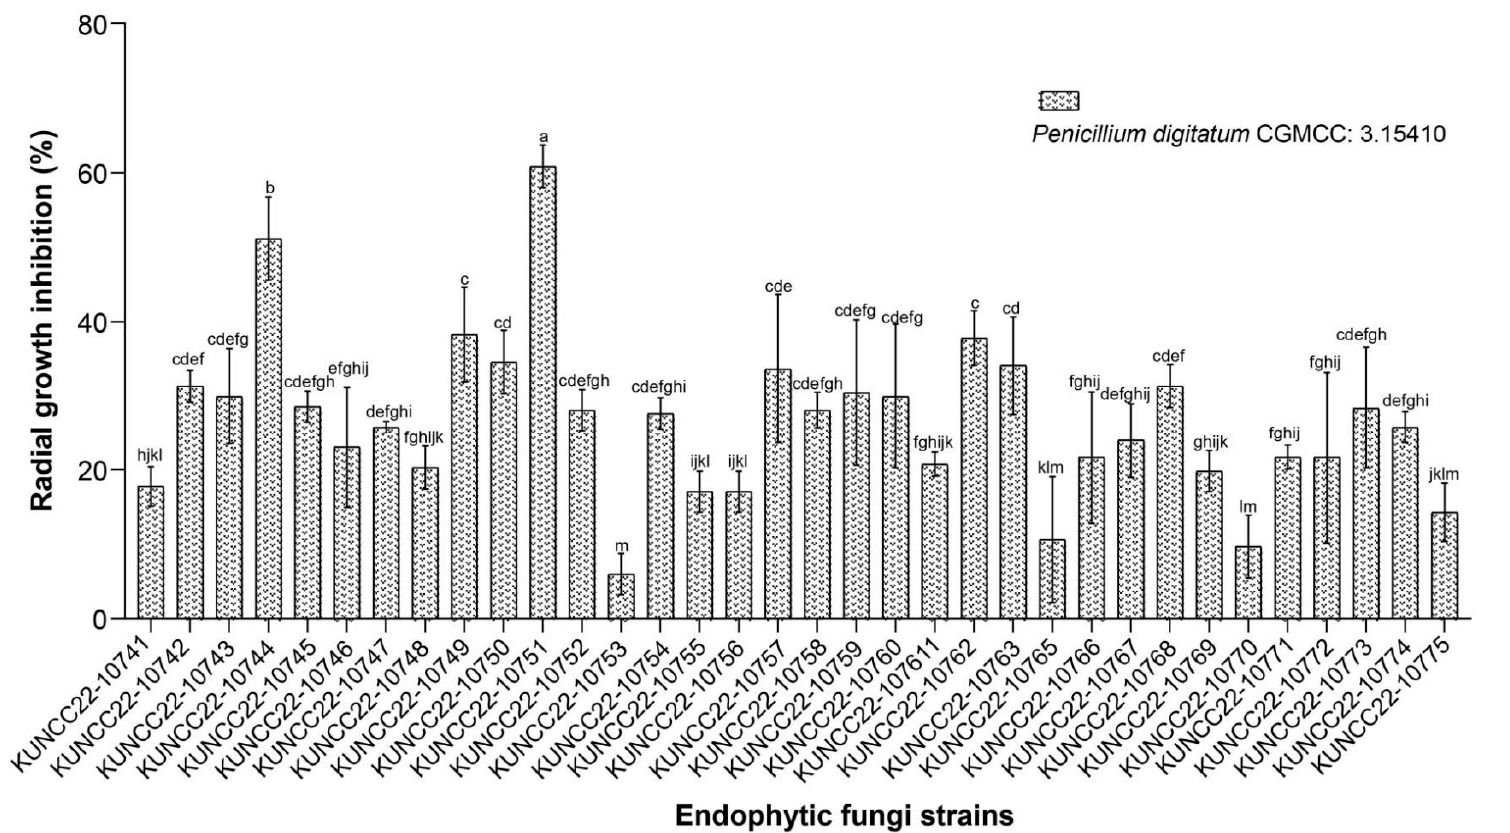
Figure 9. Inhibition rates of different fungal endophytes to fungal pathogen Penicillium digitatum (GCMCC: 3.15410). The bars denoted by the same letter are not significantly different from each other .